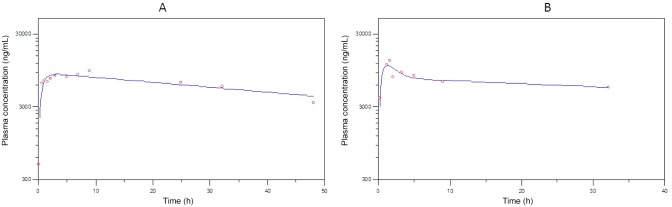
Plasma concentration versus time after dosing plot (dots) with best fit curve (lines) bird 1 (A) and 2 (B) following oral administration of phenylbutazone at 1.7 mg/kg.Samples were collected sequentially, when possible, at 5 and 30 min; 1, 1.5, 2, 3, 5, 7, 9, 12, 24, 32 and 48 hours after treatment with phenylbutazone.